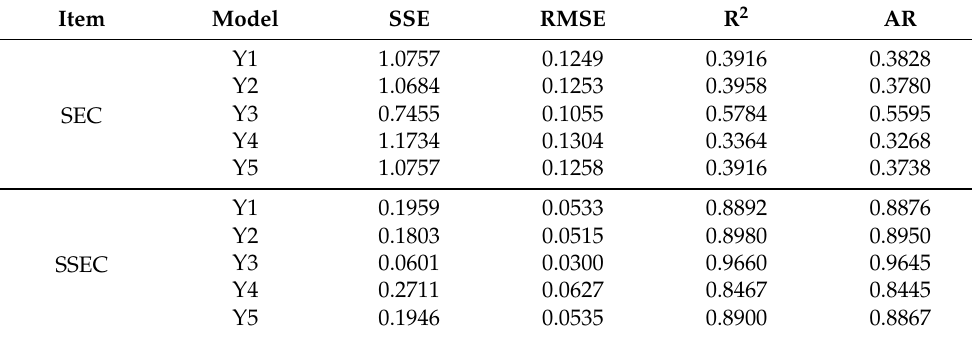
Table 5. Evaluation of the soil electrical conductivity construction model.